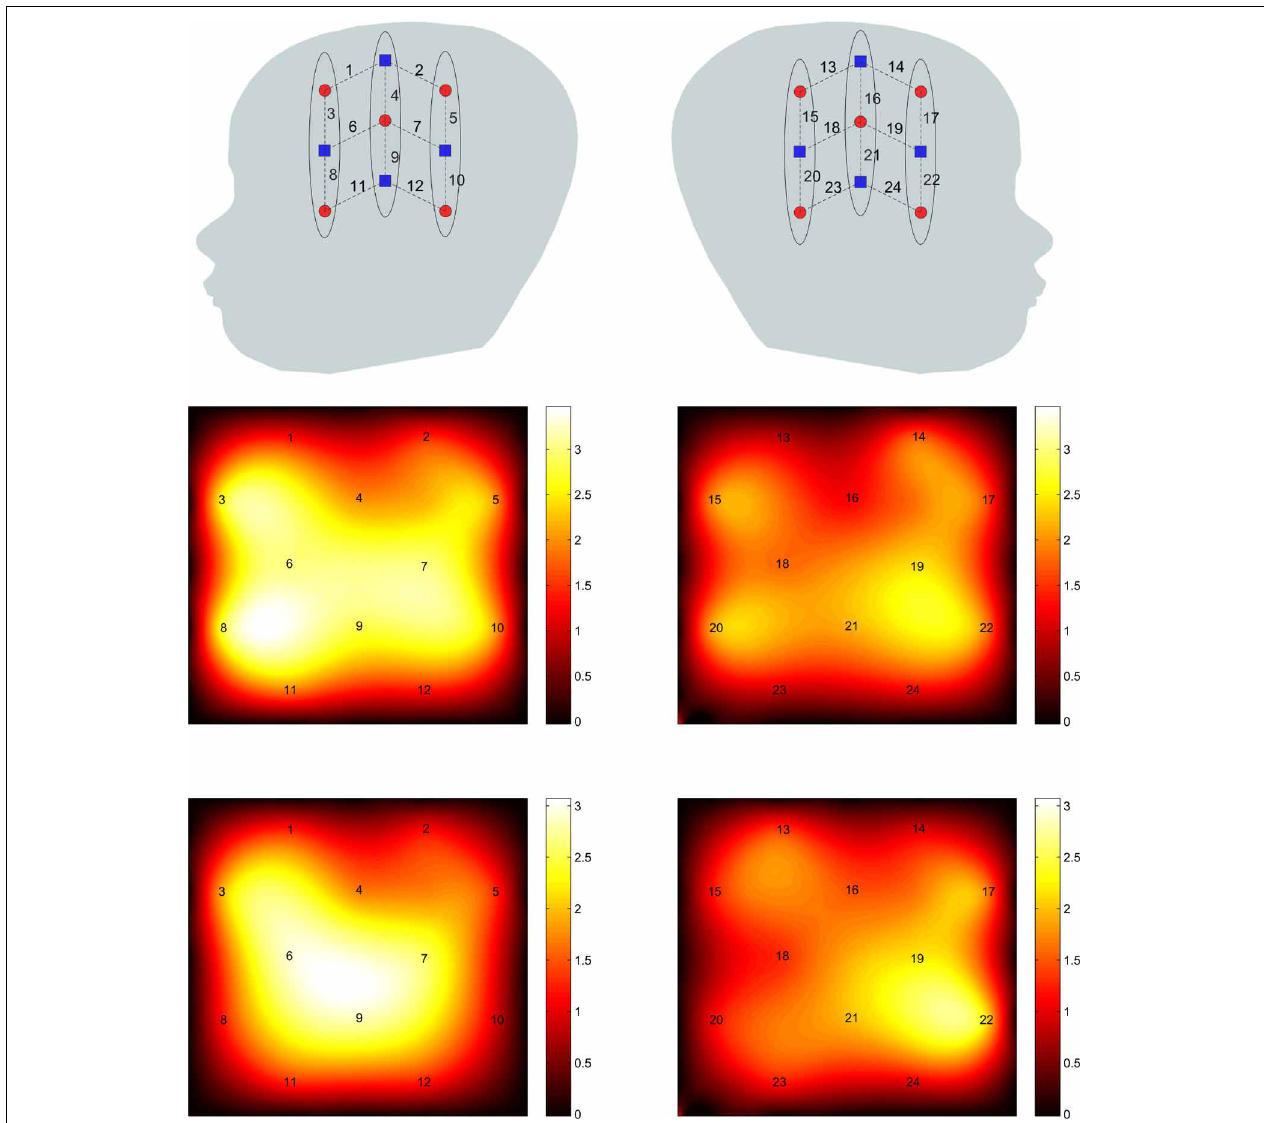
FIGURE 5 | The connectivity map for the 2 subgroups with channel 9 used as the seed channel. The top and bottom panels are results of subgroups 1 and 2, respectively. Left and right panels correspond to left and right